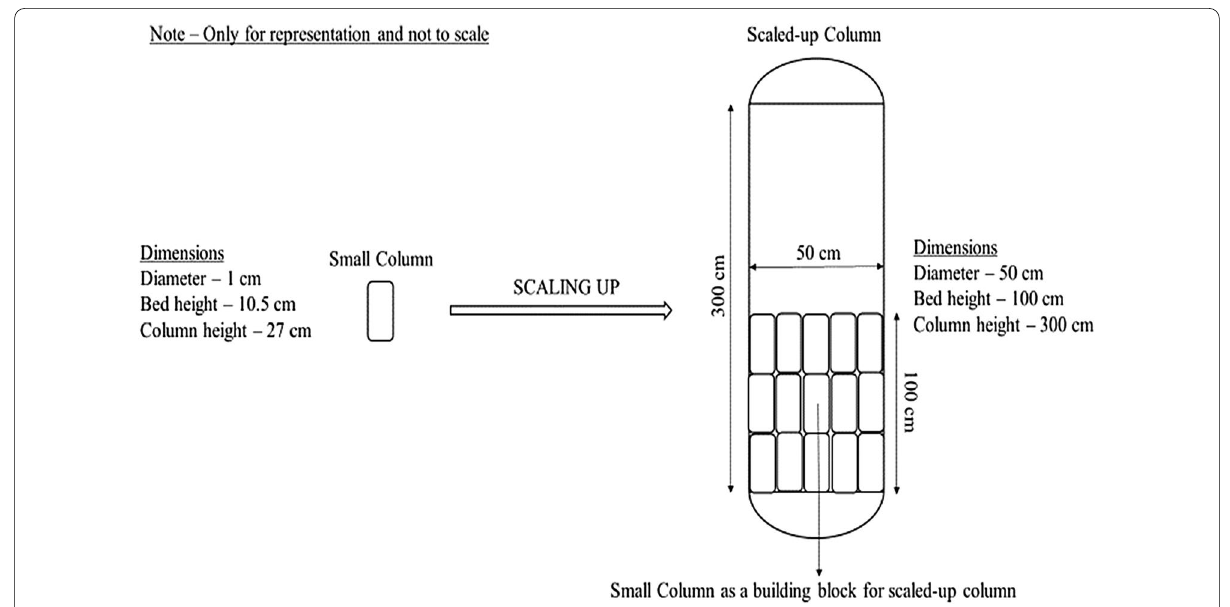
Fig. 14 Proposed scaled-up column design along with